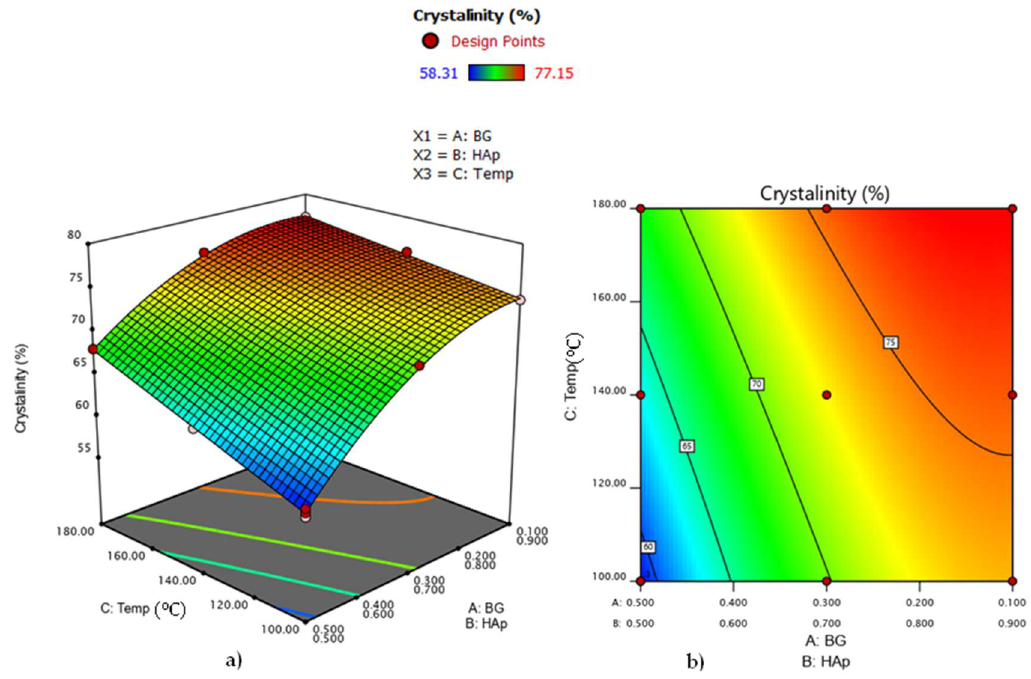
Figure 9. ( a ) 3D mixture–process diagram; ( b ) 2D mixture–process contour plot of process conditions that influence HAp/BG composite crystallinity.